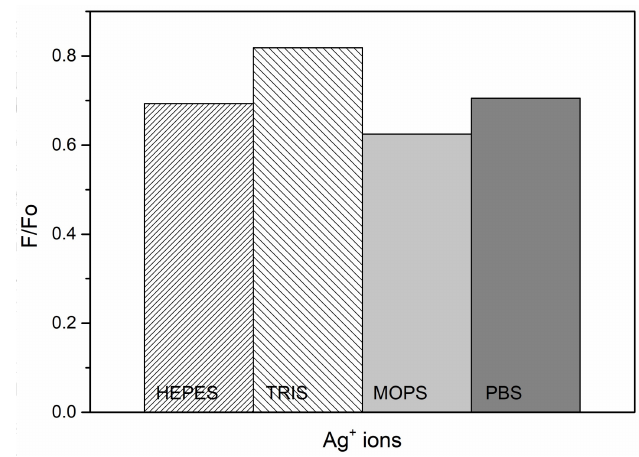
Figure 4. Buffer effect (HEPES, TRIS, MOPS and PBS) on fluorescence intensity of RhB-EDA in the presence of 10 − 4 M Ag + ions. λ ex / λ em was selected at 500/538 nm. Slit ex/em 6.0/6.0